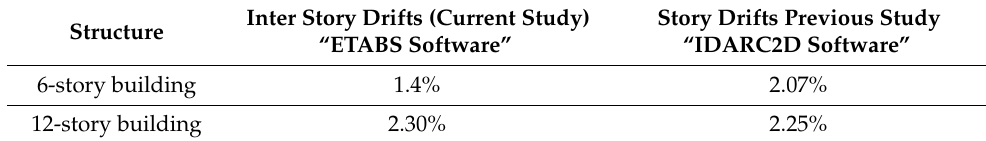
Table 3. Maximum inter-story drifts for bare frames.